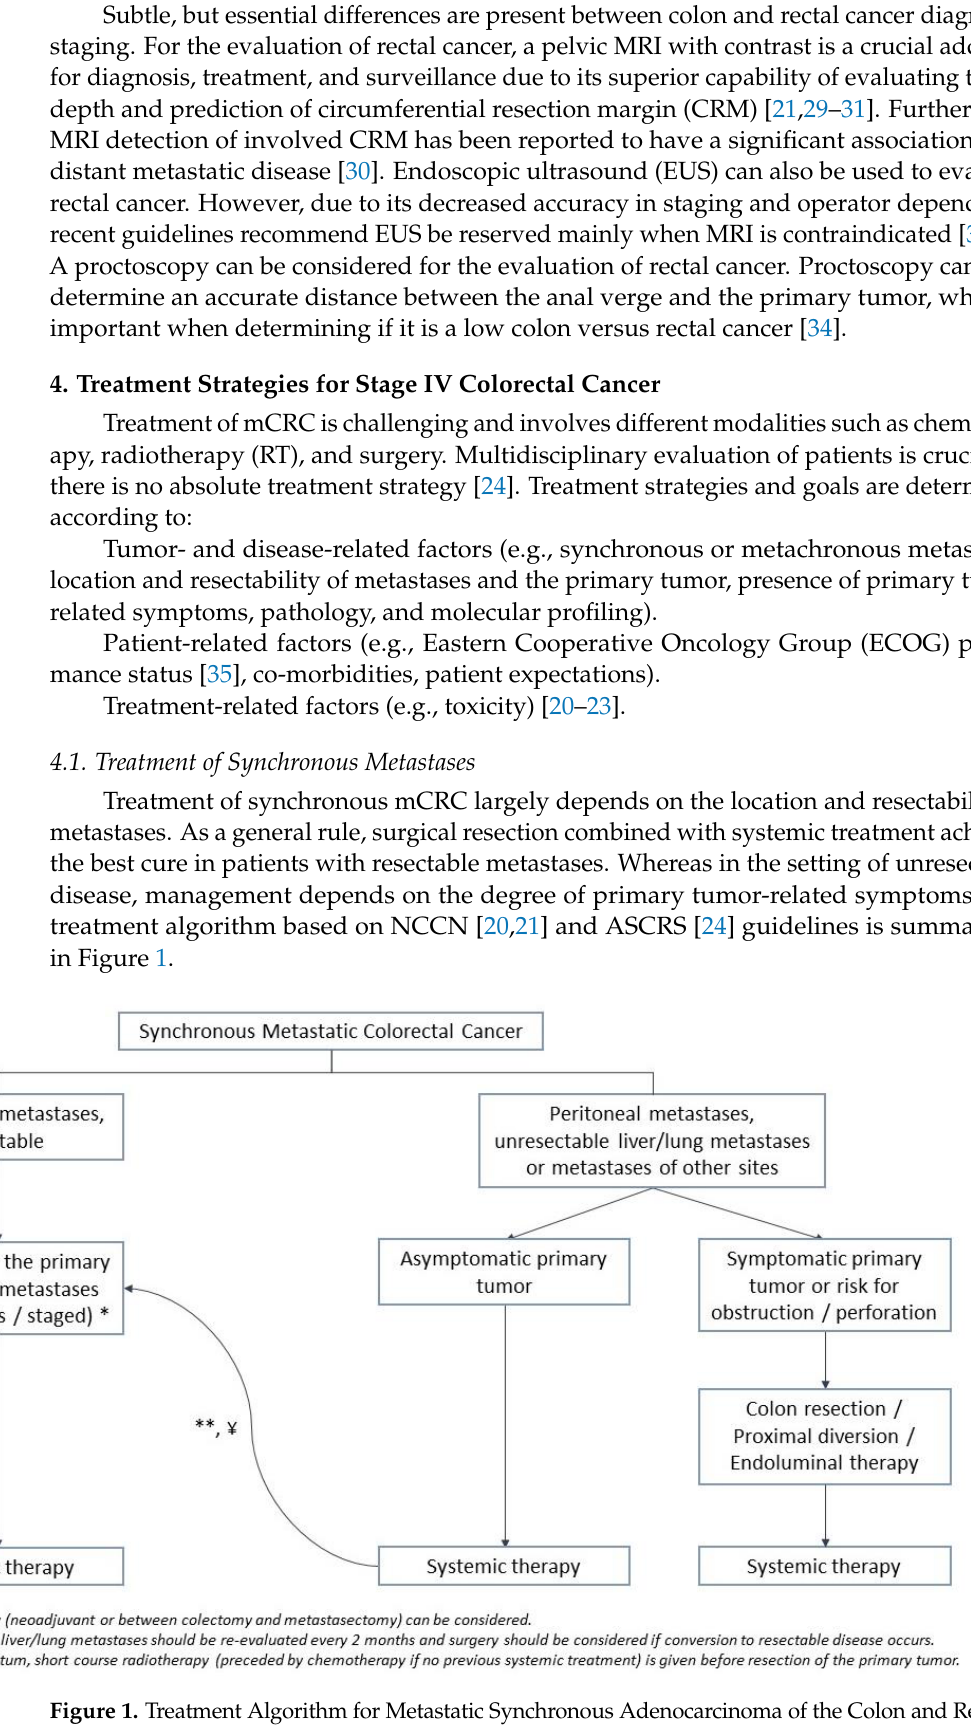
Figure 1. Treatment Algorithm for Metastatic Synchronous Adenocarcinoma of the Colon and